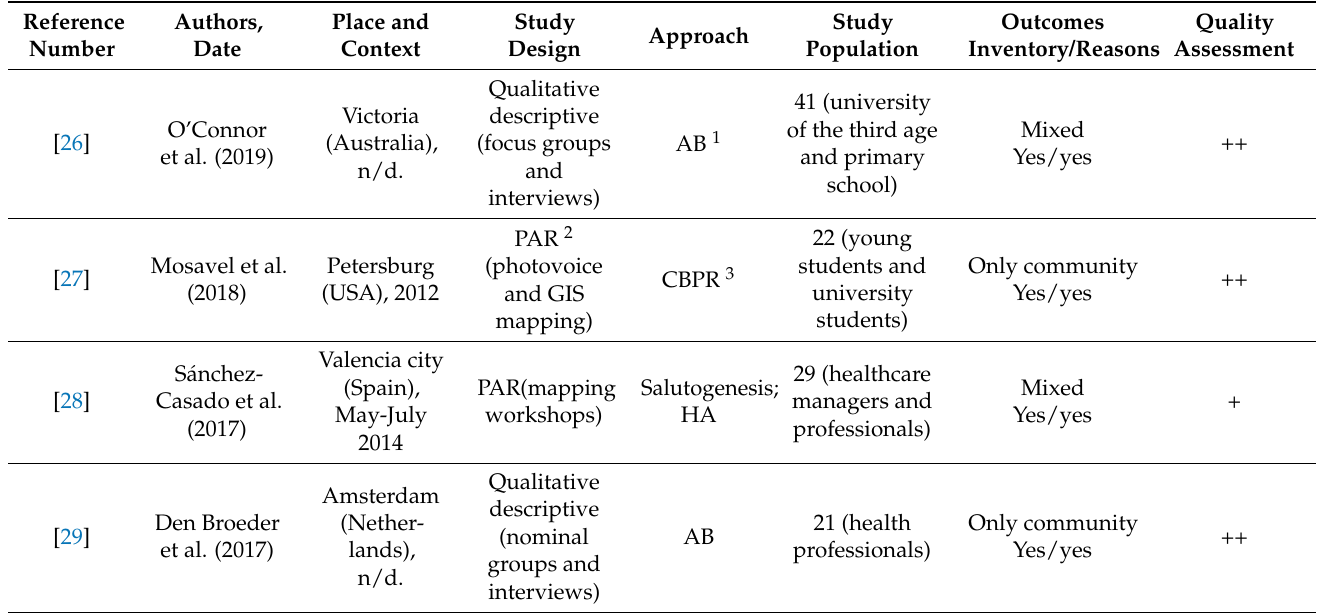
Table 1. General characteristics of the documents included. Meta-synthesis ( n